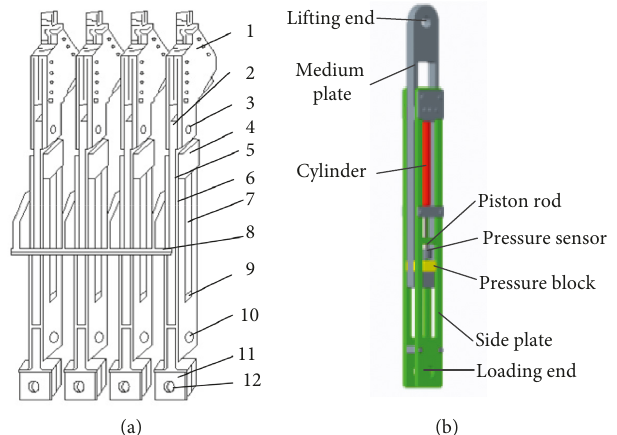
Figure 1: Structure of wire rope tension balance hydraulic connection device.1, wedge-shaped rope ring; 2, medium plate; 3, top connecting pin; 4, baffle; 5, pressure plate; 6, side plate; 7, connecting cylinder; 8, connecting device; 9, pressure block; l0, middle connecting pin; 11, reversing fork; 12, connecting